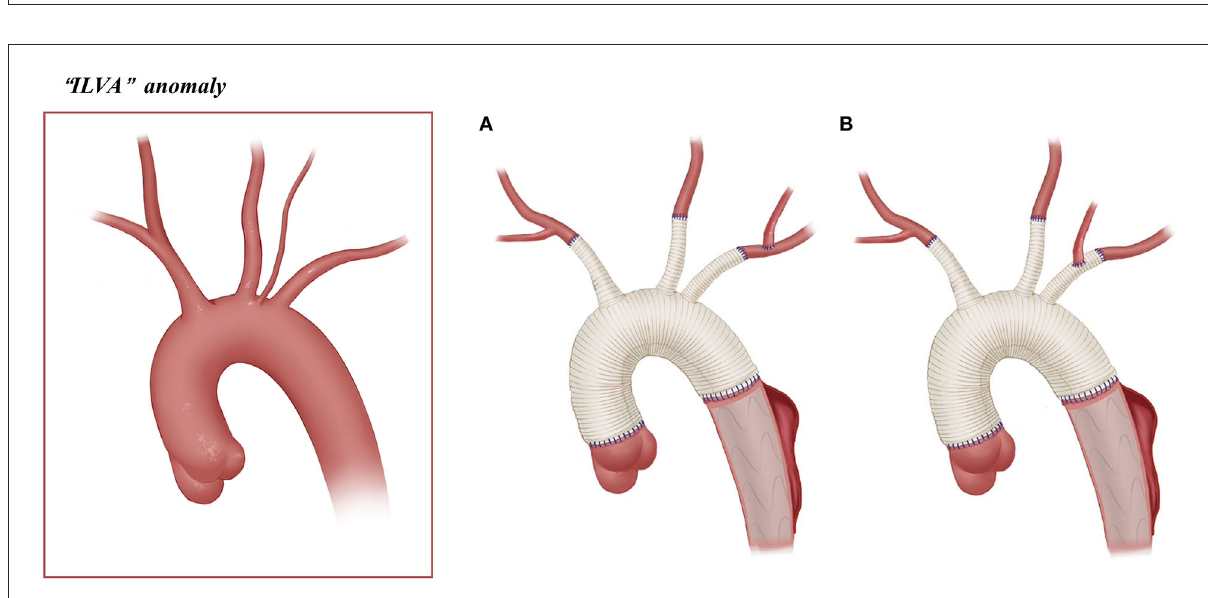
FIGURE4 Arch technique for “ILVA” anomaly in patients with type A aortic dissection. (A) ILVA anastomosed to the LSA. (B) ILVA anastomosed to the LSA graft branch.